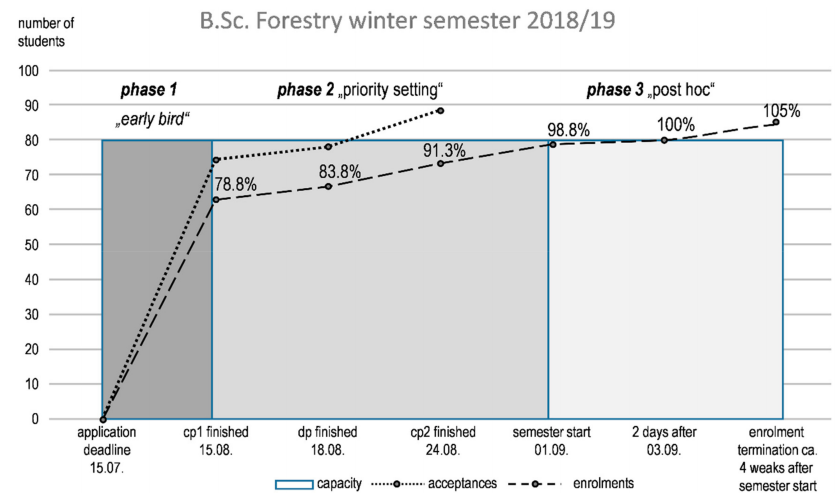
Figure 2. Analysis of students applying, oriented to the schedule for Dialogue-oriented service Procedure (German abbreviation DoSV). Cp 1: coordination phase 1 (activation of the ranking lists): 16.07.–15.08.; dp: decision phase; cp 2: coordination phase 2: (further proposals and acceptances): 19.08.–27.08.; 24.08.: automatic approval and electronic distribution of notices. Conceptual design: T. Nern / HAWK.